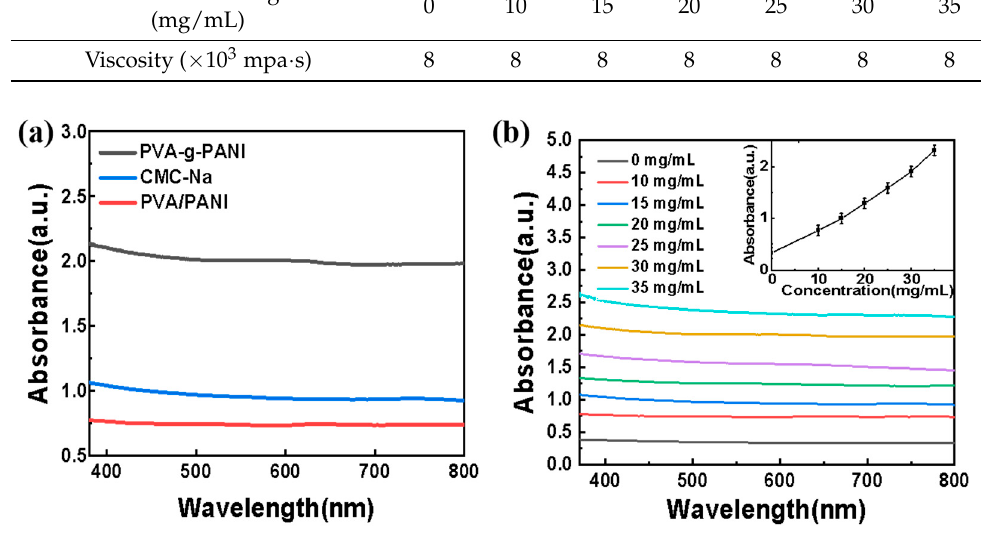
Table 1. Effect of different concentrates of PVA-g-PANI on graphene dispersion. Concentrates of PVA-g-PANI